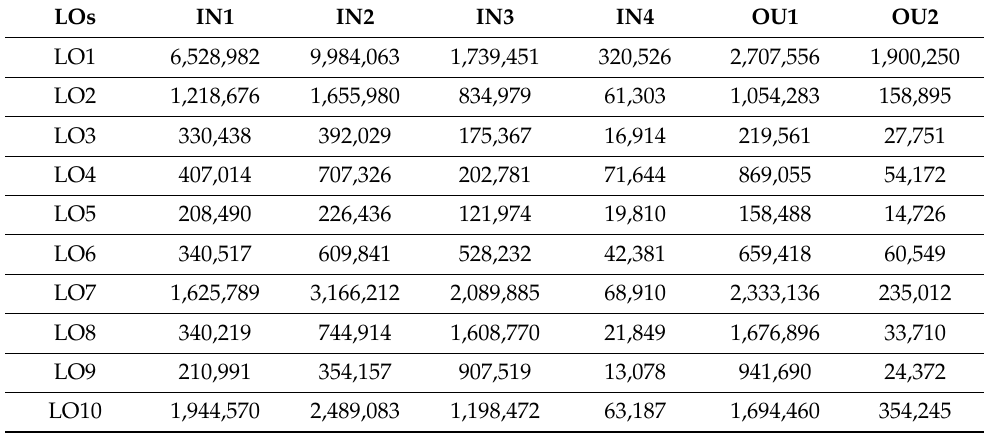
Table 3. Data of 10 LOs in 2018 (Statistics 2021).